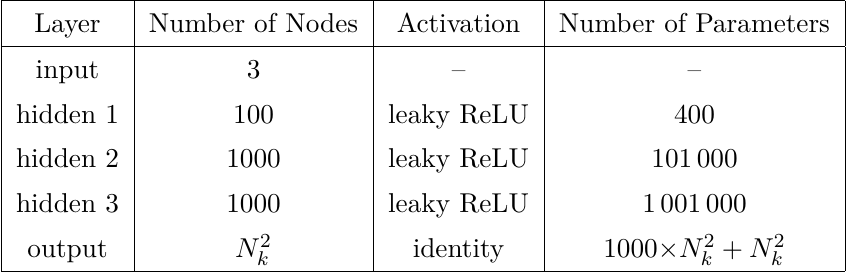
the NN for 200 epochs with stochastic gradient descent, ADAM optimizer and L decay with parameter 0 . 001 . This takes less than a minute and is orders of magnitude faster than re-computing H for a given value of ψ